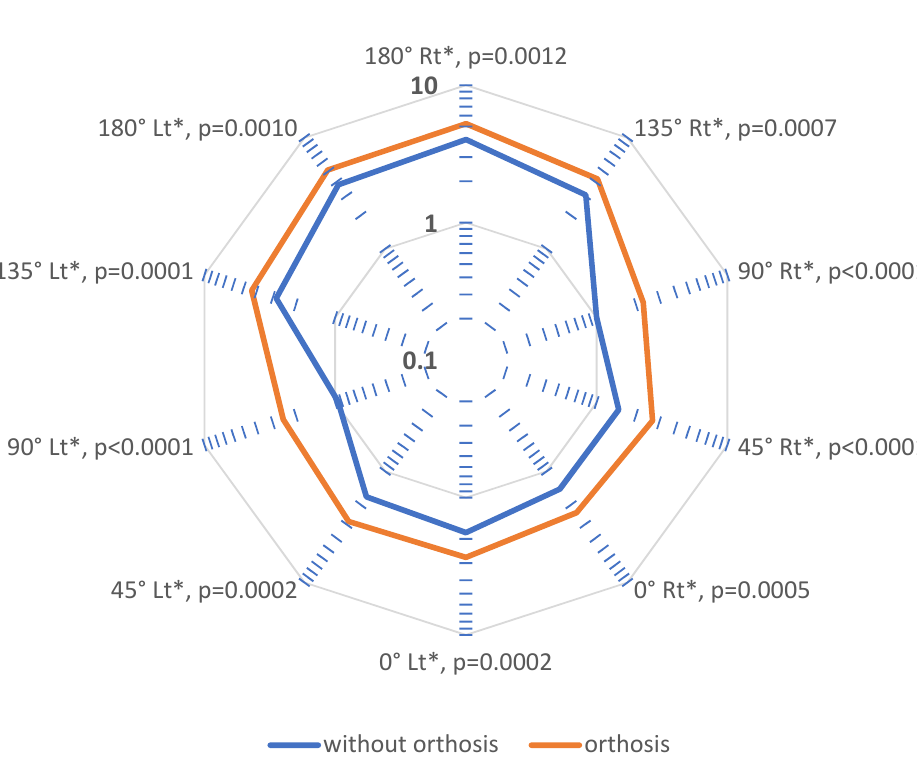
Figure 4. Ratings of perceived exertion (RPE) using radar plot in Reach stage, i.e., maximum trunk sway from neutral position. The blue line represents without orthosis condition, while the orange line represents orthosis condition. Each axis of the plot represents the 10 tasks, i.e., at five orientations (0°, 45°, 90°, 135°, and 180°) using two limbs (Rt: right limb, Lt: left limb). The axes are plotted using logarithmic scale between 0 and 10. An asterisk in axis label indicates a significant difference in the RPE rating between orthosis and without orthosis conditions, and the p -values are also shown.